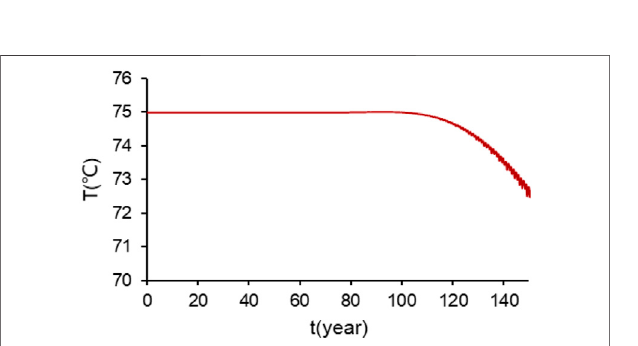
FIGURE 7 | When the well spacing is 600 m and the water yield per production well is 223.64 m 3 /h, the temperature of the production well changes with the production time.